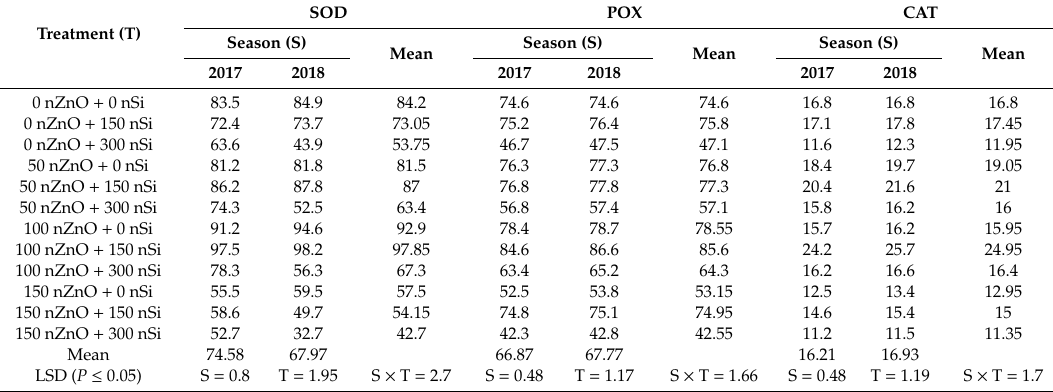
Table 5. E ff ect of foliar spray with ZnO and Si NPs (mg / L) on the superoxide dismutase (SOD), peroxidase (POX), and Catalase (CAT) activity ( µ / min / g fw) of “Ewais” mango trees during the 2017 and 2018